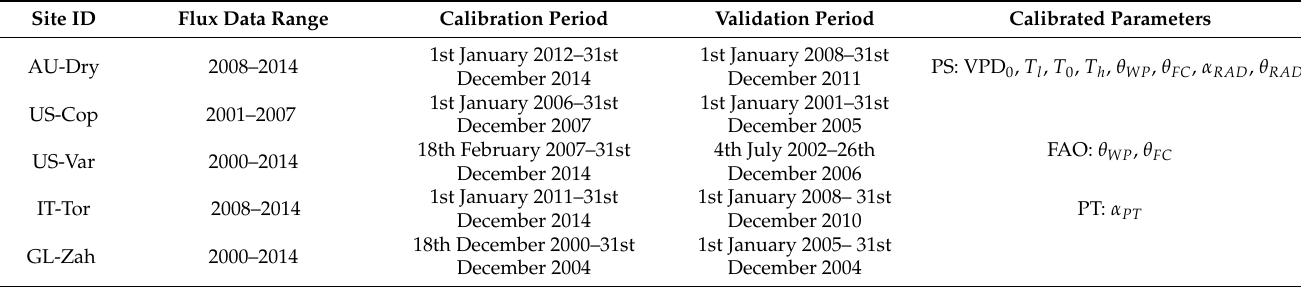
Table 2. Calibration period, validation period and calibrated parameters for each Site and model. Note that VPD 0 , T l , T 0 , T h , θ WP , θ FC , α RAD , θ RAD , α PT , respectively, stand for vapour pressure deficit, lower, optimal and higher temperature, the water content at wilting point, the water content at field capacity, the slope and the shape parameters of the total solar radiation stress function and the PT